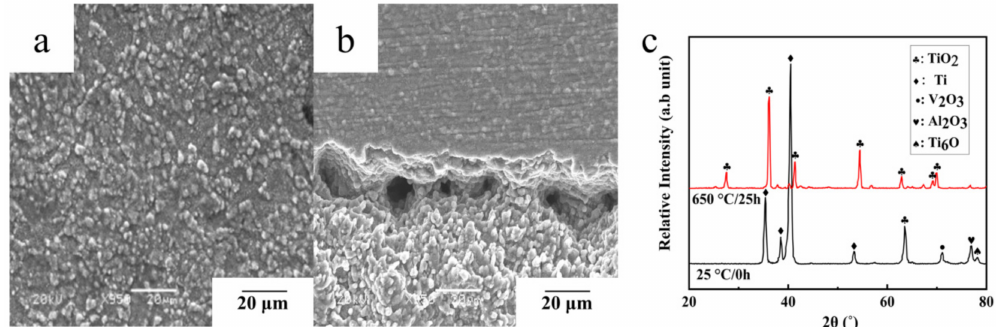
Figure 2. Surface micrographs of untextured ( a ) and textured ( b ) samples after thermal oxidation and X-ray diffraction patterns of non-oxidized and oxidized surfaces ( c ).